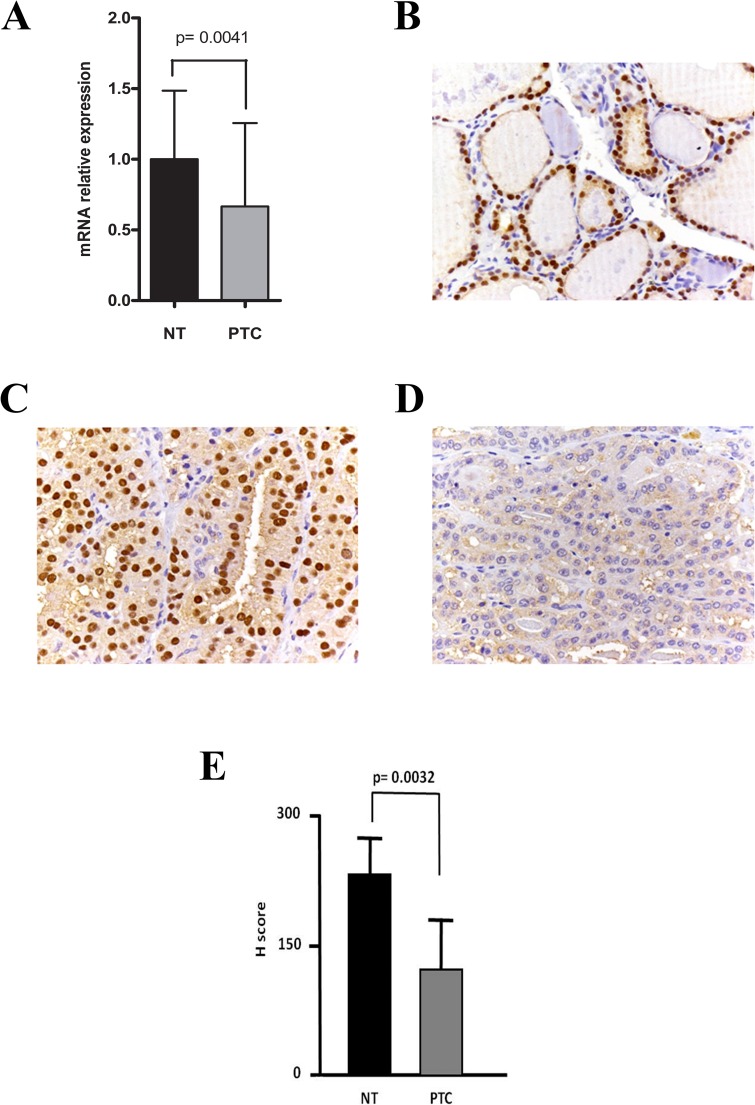
PAX8 expression in normal and tumor thyroid tissues of PTC patients.(A) Mean (SD) PAX8 mRNA levels found in normal thyroid tissuesamples (n = 18) and PTCs (n = 36), assessed by qPCR. (B-D) Representative images of immunohistochemical staining for PAX8 protein levels in (B) normal thyroid tissues; (C) PAX8-positive PTCs; and (D) PAX8-negative PTCs. (E) Mean H scores for immunohistochemical labeling of PAX8 protein in normal thyroid tissues (12 samples) and PTC (38 samples).